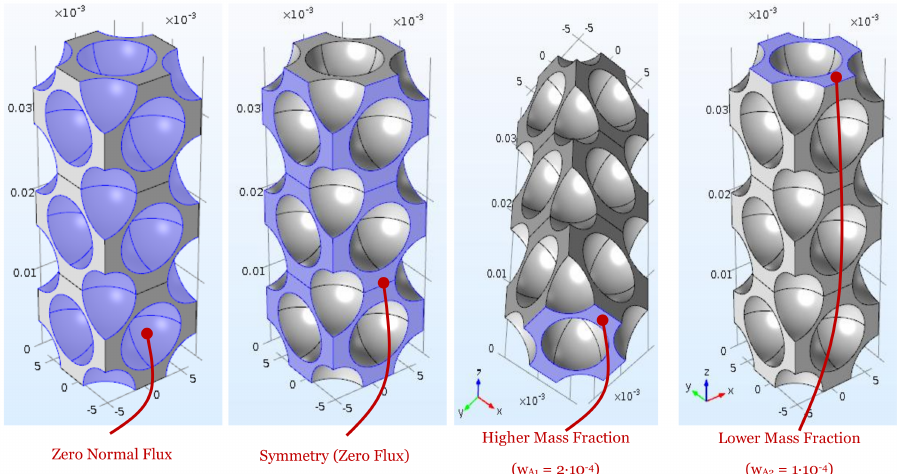
Figure 7. Boundary conditions used for simulation. Visualisation example for the FCC structure.